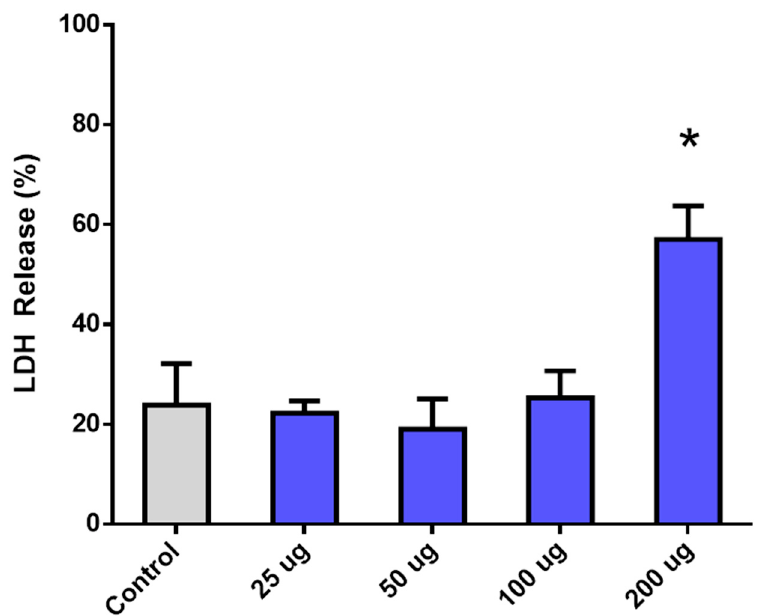
Figure 12. Cell viability assay representing the percent of LDH release of Bend.3 endothelial cells treated with increasing amounts of HMMSN hybrid magnetic mesoporous nanorods. Values are normalized to a positive control for cell death. (N = 8/groups, * = p < 0.005 compared to the control group).